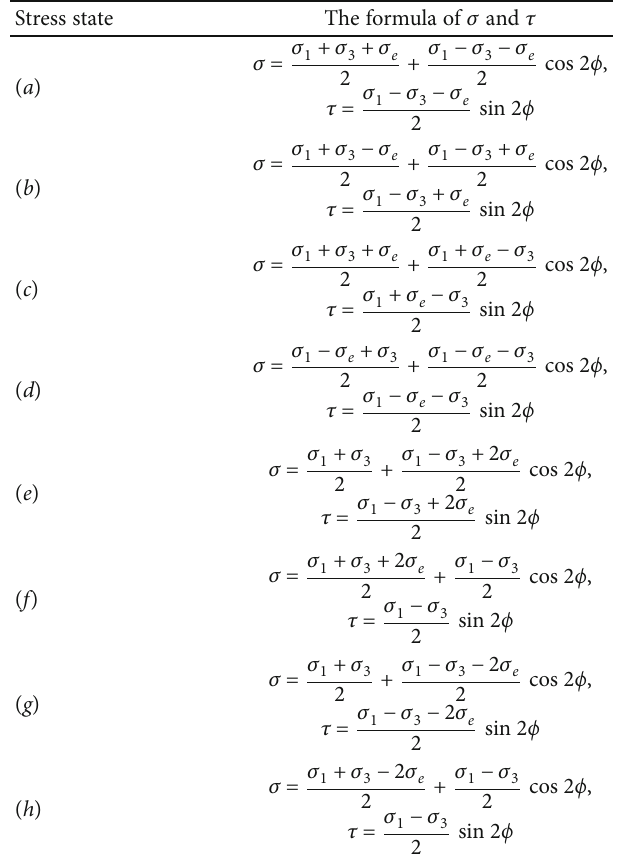
Table 2: The strength analysis criterion of rock joints. Table 1: The stress expression of rock